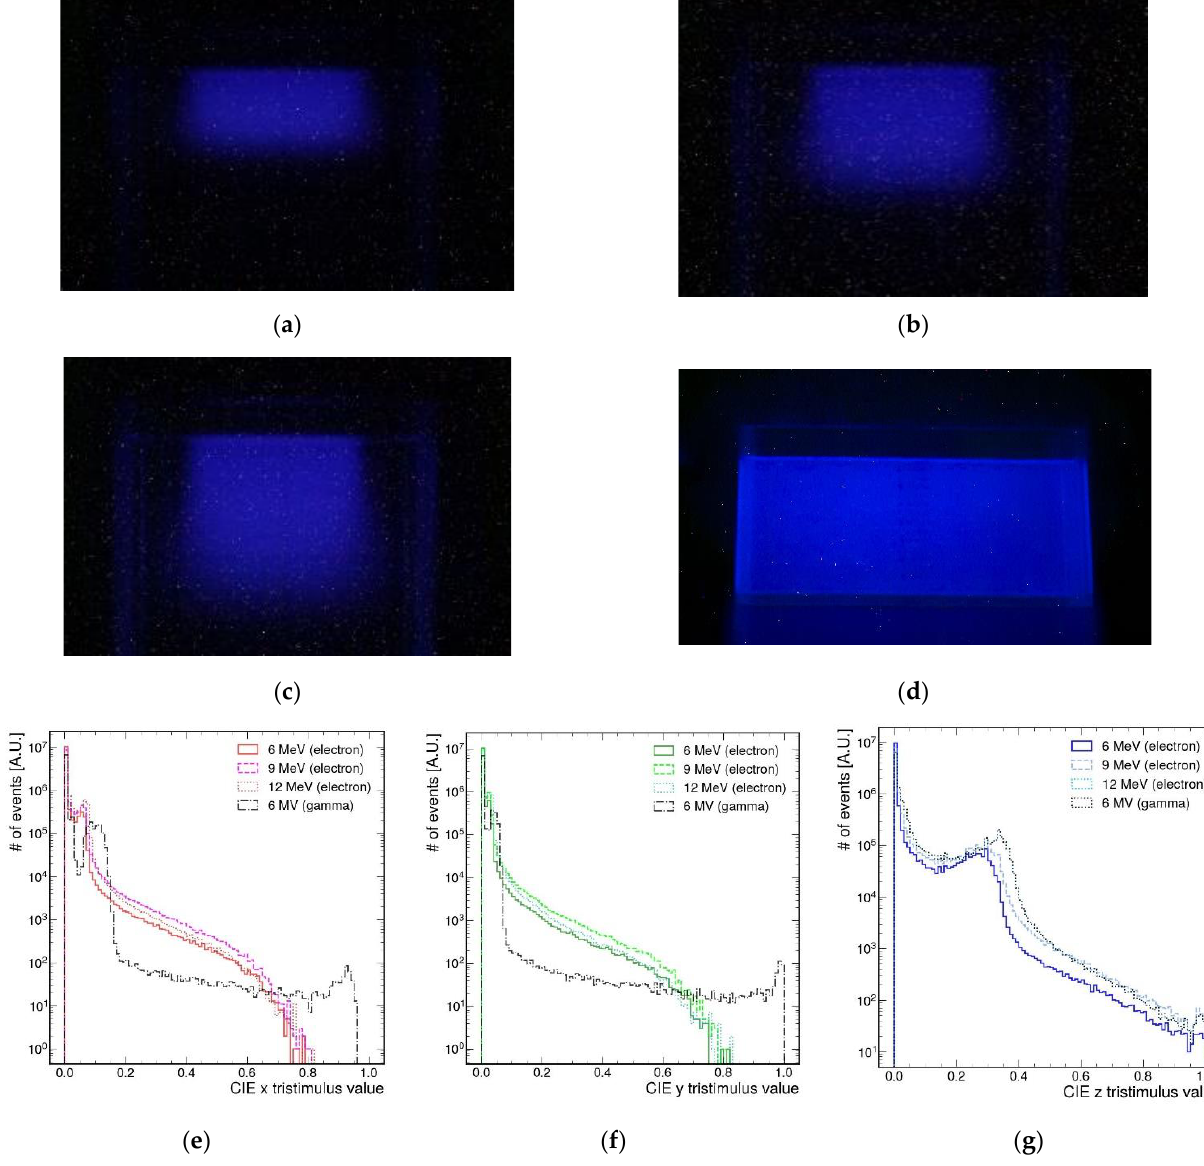
Figure 2. Subfigures ( a – c ) represent the fluorescent light of AbLS with 6, 9, and 12 MeV electron beams, and ( d ) represents the fluorescence of gamma rays from 6 MV electron. For electron beam or gamma rays, Varian Novalis Tx system was used. The beam was injected from top to bottom. The fluorescent light from AbLS is seen in the central part of the container. The glimmering light seen at the top and the bottom of the picture is due to the reflection from the container. ( e – g ) Decomposed histograms were based on CIE XYZ for each fluorescence image. RGB components were extracted from the photographed images in ( a – c ). Peaks around 0.3 in the z-value distribution were seen, compared to those of the x value or y value. Blue component was more dominant compared to the red and green